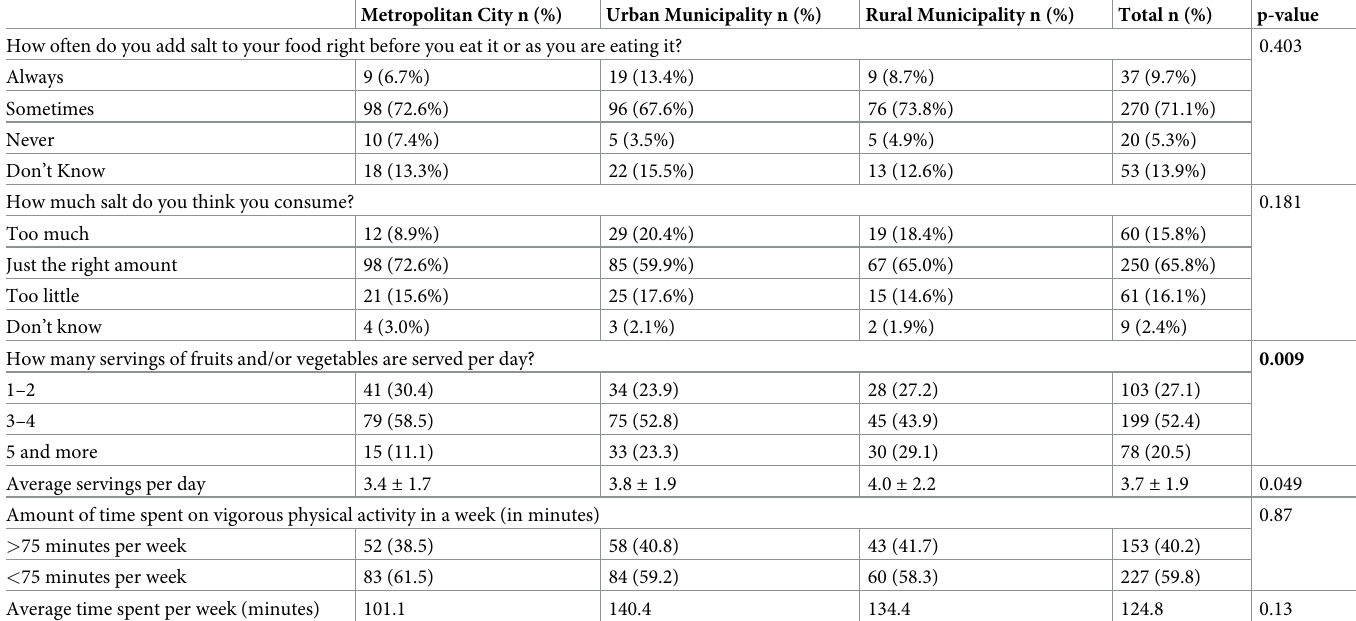
Table 6. Respondents’ practice behaviors regarding diabetes and hypertension.